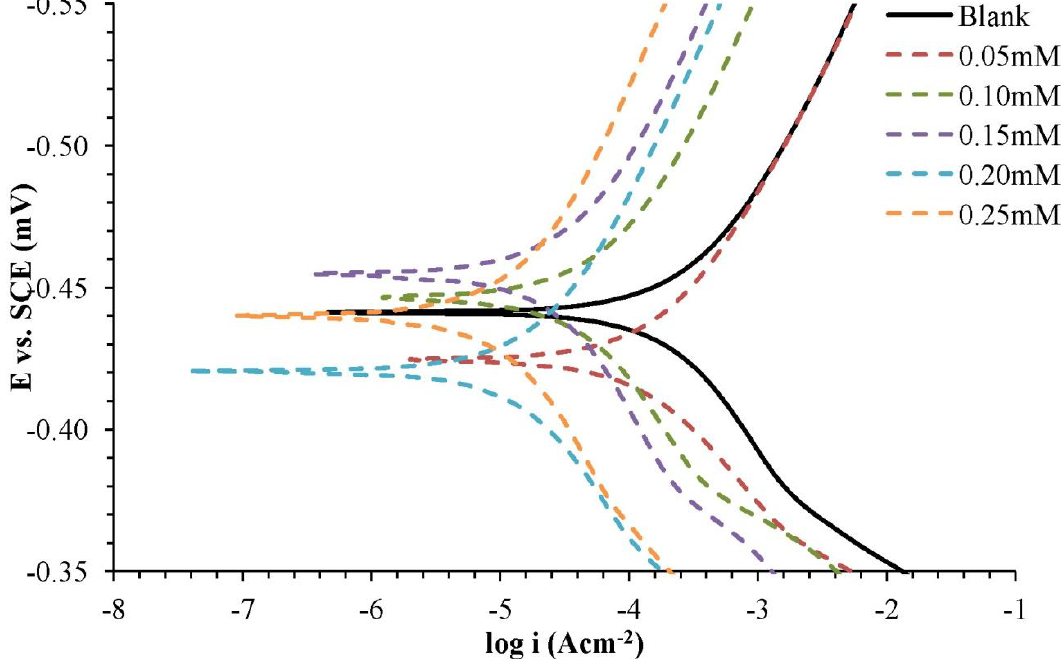
Figure 3. Potentiodynamic polarization curve for mild steel in 1.0 M H concentrations of the corrosion inhibitor at 30 °C. SCE, saturated calomel electrode.